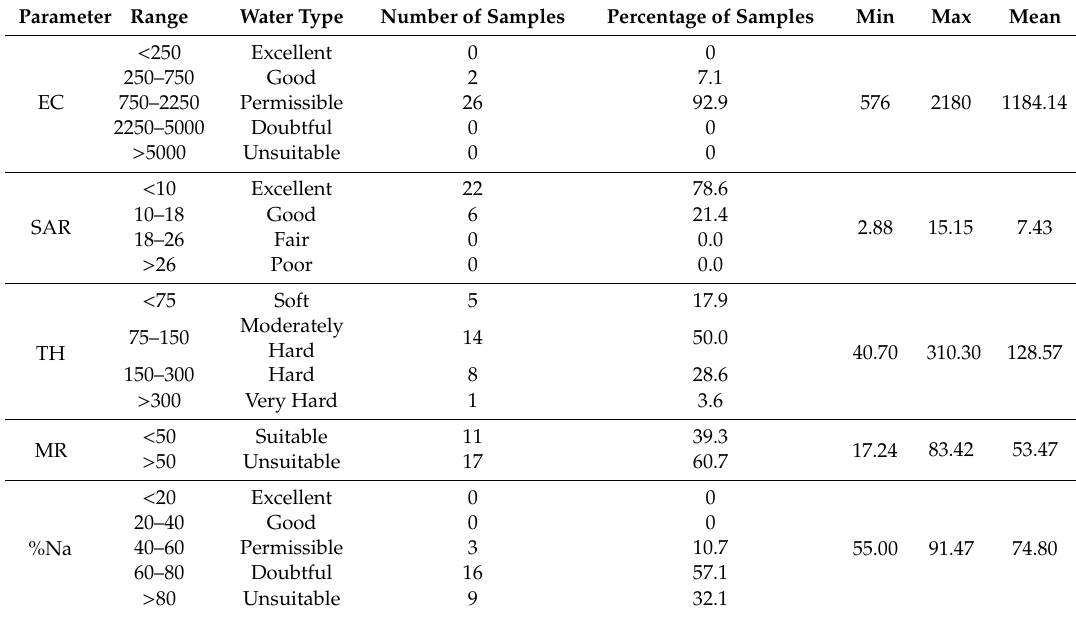
Table 7. Statistical summary and classification of groundwater quality parameters for irrigation purposes (Source modified by researchers